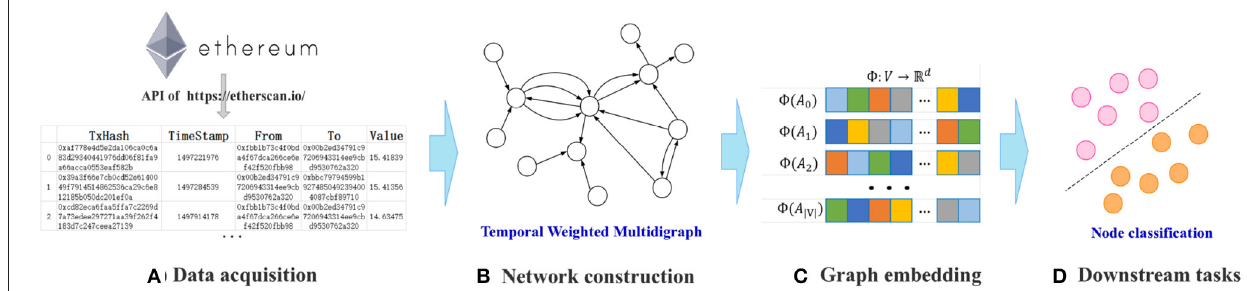
FIGURE 1 | The architecture of the proposed framework for network analysis of Ethereum.